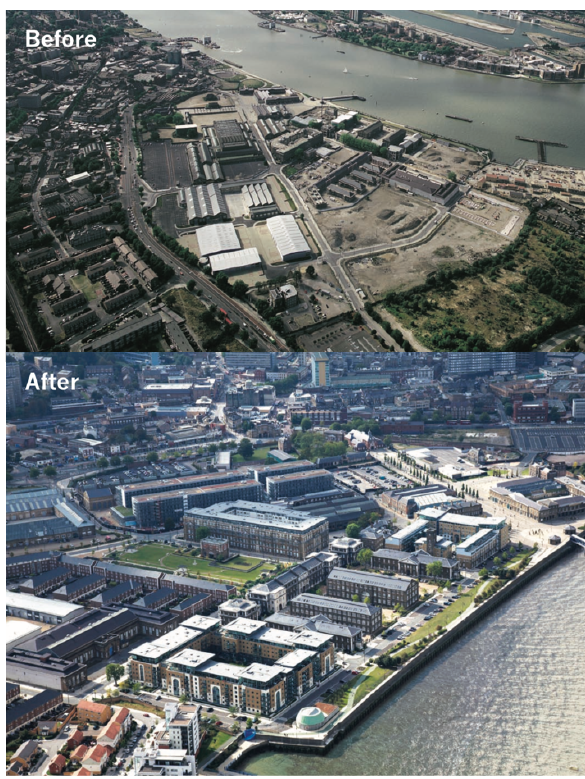
Figure 1: Royal Arsenal, before and after the regeneration © BHL